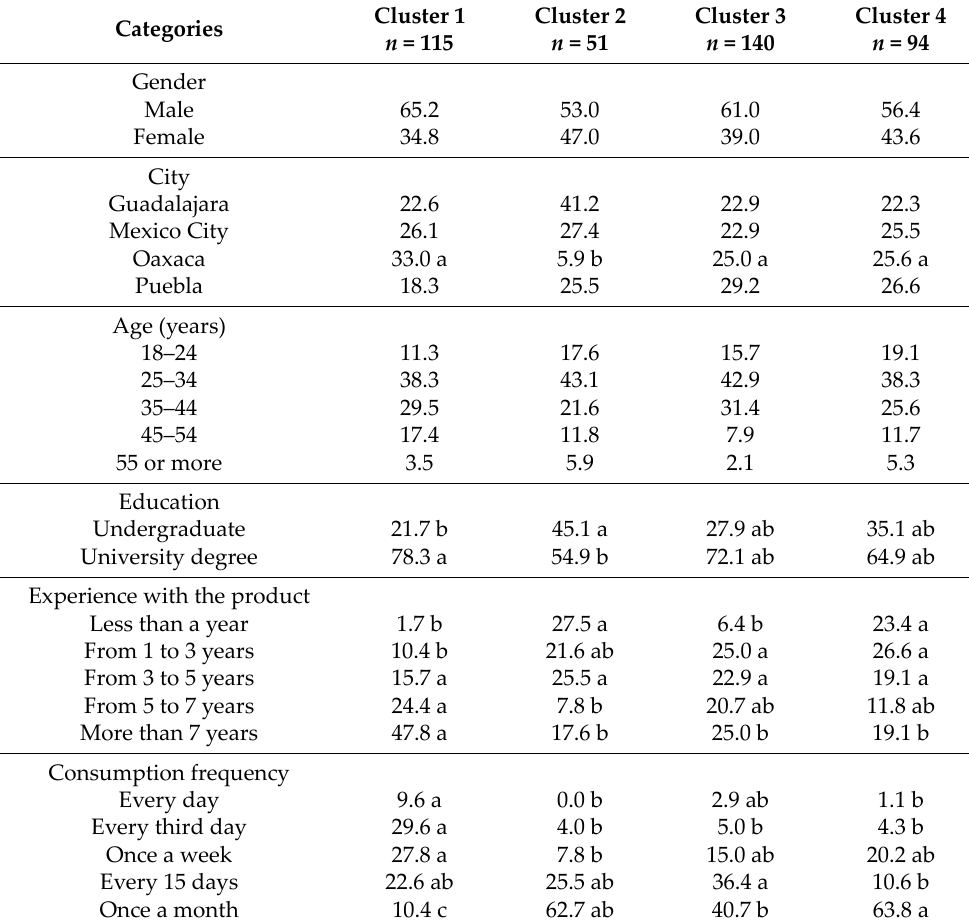
Table 6. Proportions of sociodemographic characteristics, consumption habits, and product experi‑ ence of mezcal segments ( N =